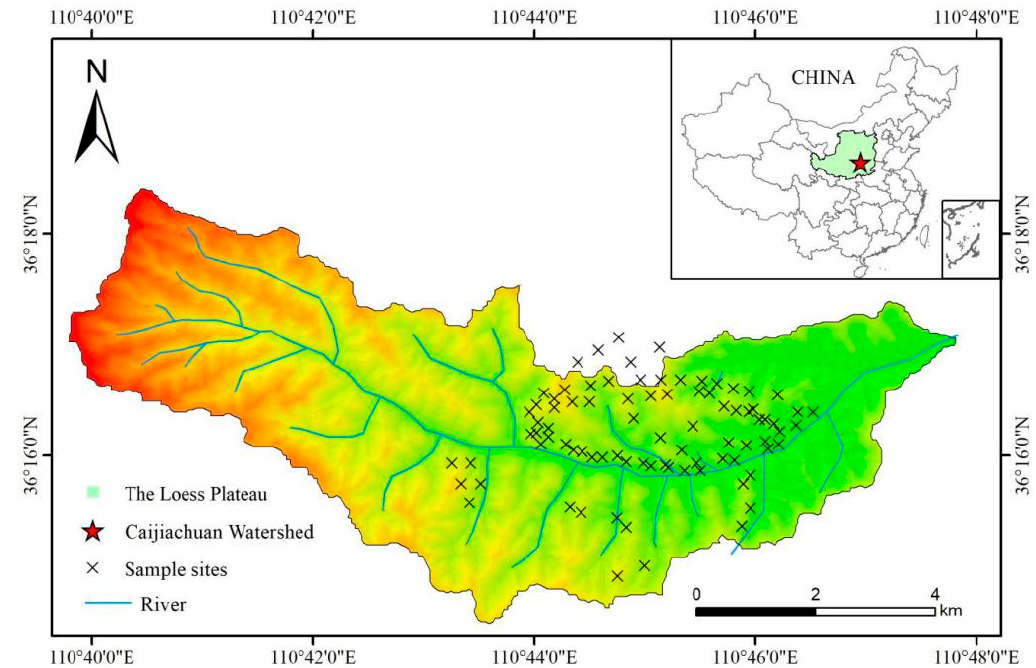
Figure 1. The location of the study area and sampling sites at the Caijiachuan watershed of the Loess Plateau, China.